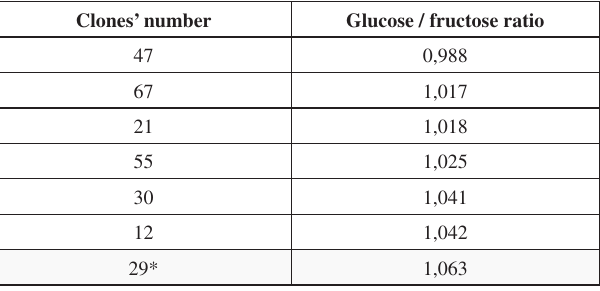
Table 9. Glucose – fructose ratio of Lycium genotypes in 2011.